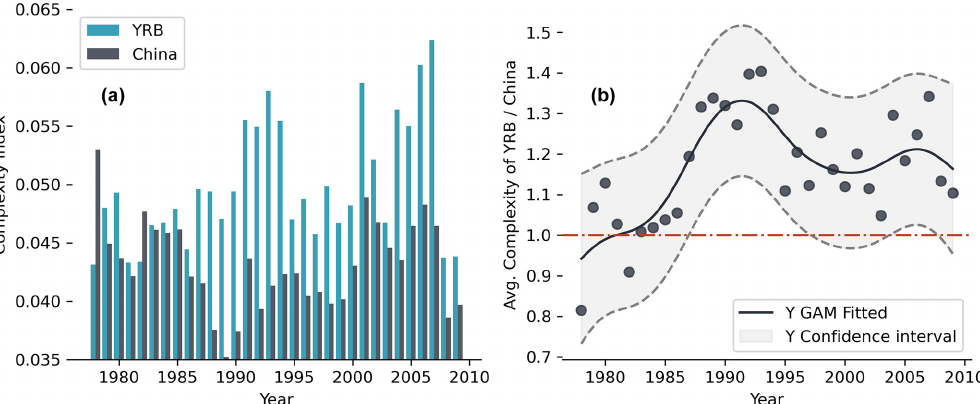
Figure 3. (a) Average complexity index of YRB and of China from 1978 to 2008. (b) Ratios of average complexity index of YRB to that of China from 1978 to 2008. The solid line was fitted with generalized additive models (GAMs). The grey shaded area indicates a 90% confidence interval. The red dashed line indicates the baseline where the average complexity index of the YRB is equal to that of